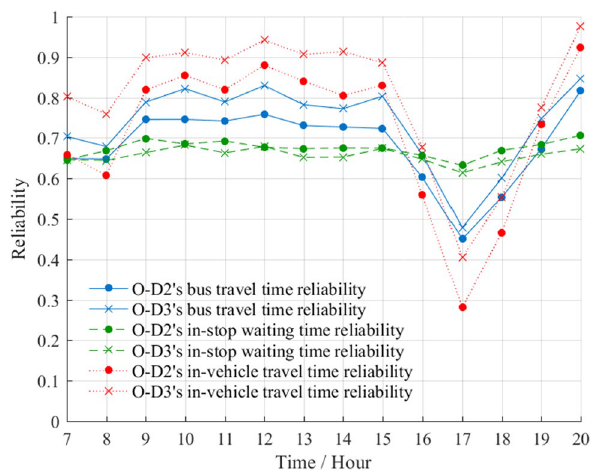
Fig. 8 Reliability in different